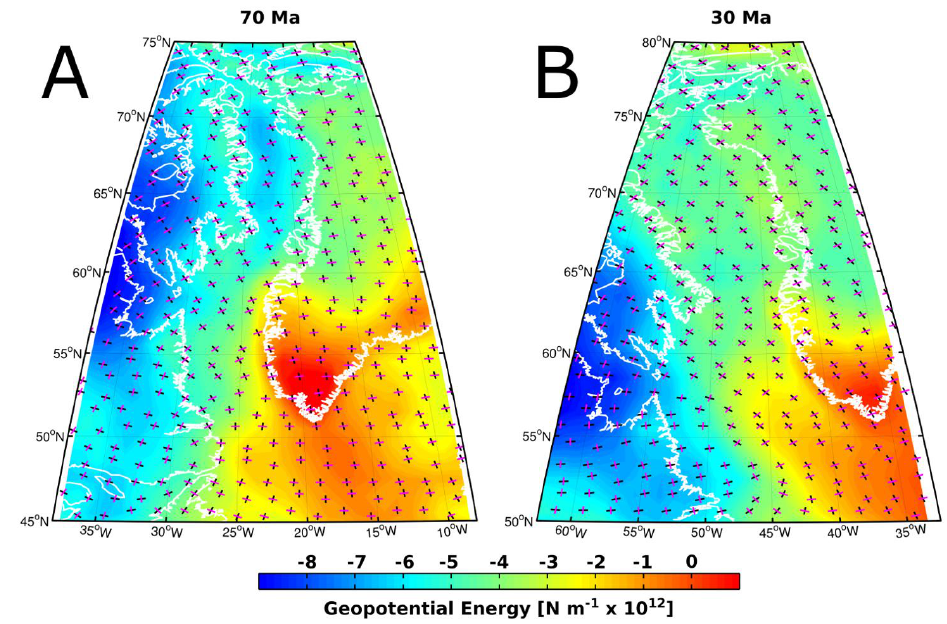
Figure 15. Geopotential energy and geopotential stresses calculated for Labrador Sea, Baffin Bay, and environs at reconstructions at ( A ) 70 Ma and ( B ) 30 Ma. Pink bars show the direction of maximum horizontal deviatoric stress (extension). Black bars show the direction of minimum horizontal deviatoric stress (compression). High geopotential energy ( GPE ) (red colours) is observed in areas of high topography and shallow lithosphere. Vice-versa, low geopotential energy corresponds to thick cratonic keels, low topography, and sedimentary basins. Positive sub-lithospheric pressure anomalies, pushing up the lithospheric column, therefore, increase GPE . In contrast, the stress field at 30 Ma, after the opening of the Labrador Sea and Baffin Bay, only slightly rotated anti-clockwise in Baffin Bay and Davis Strait. However, along the Labrador coast, stress directions changed dramatically to coast-parallel extension from previously coast- perpendicular extension, while in the central and eastern Labrador Sea and Southwest Greenland,